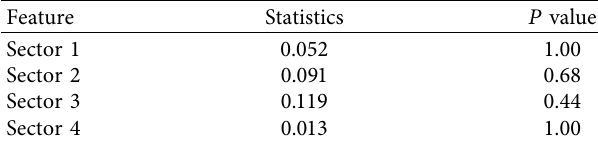
Table 5: Kolmogorov–Smirnov goodness of fit test.